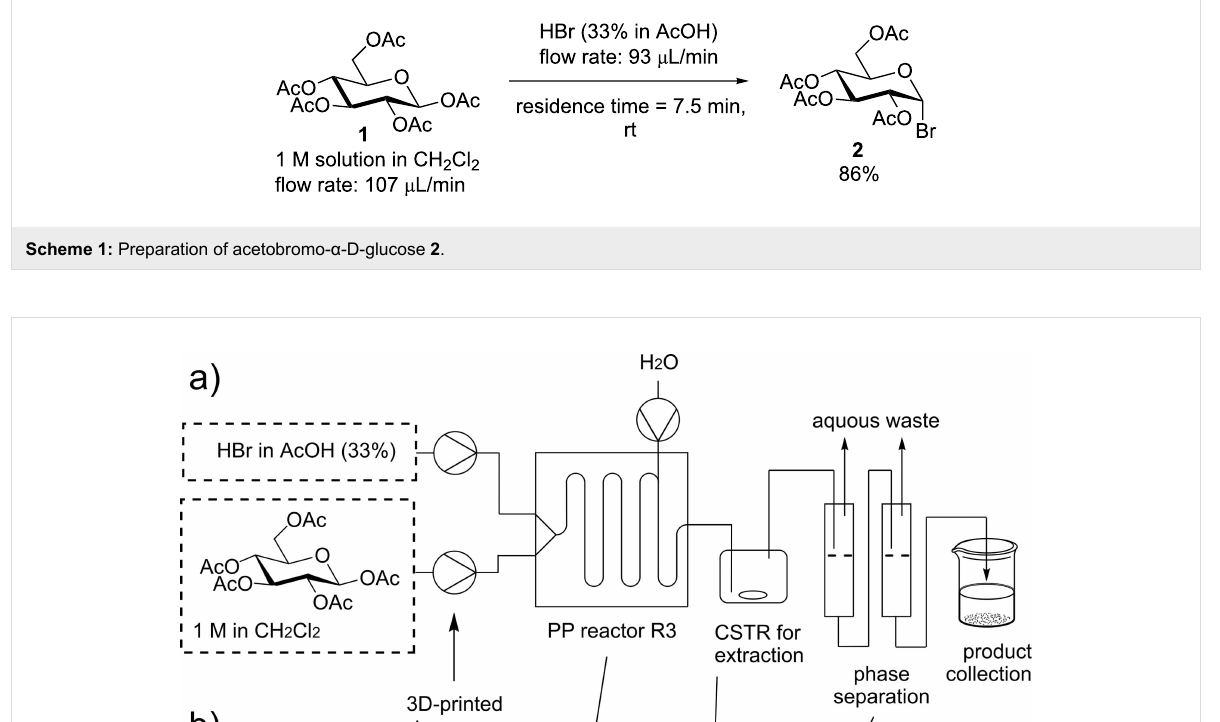
CSTR device and two syringes for phase separation